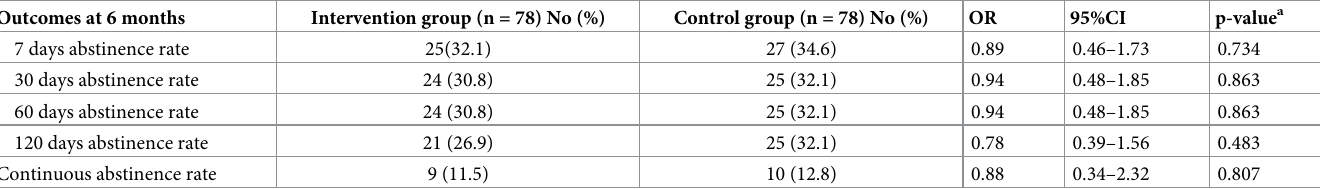
Table 2. Continuous abstinence rate at 6 months between the intervention and control groups.